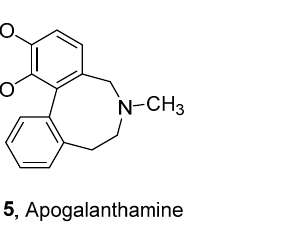
Figure 2. Representative examples of bioactive 5,6,7,8-tetrahydrodibenzo[ c , e ]azocine.